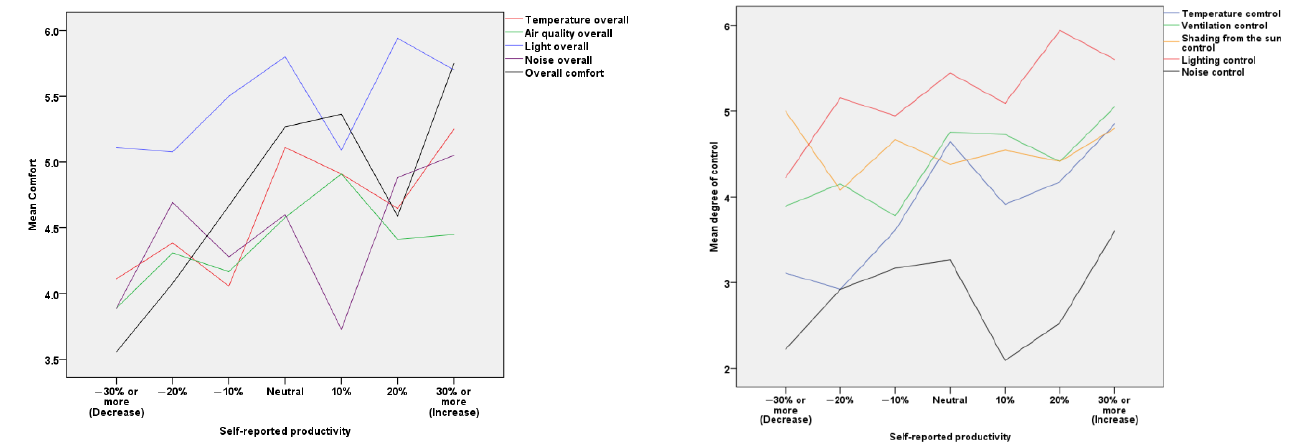
Figure 6. Self-reported productivity in comparison with perceived comfort and control of the IEQ